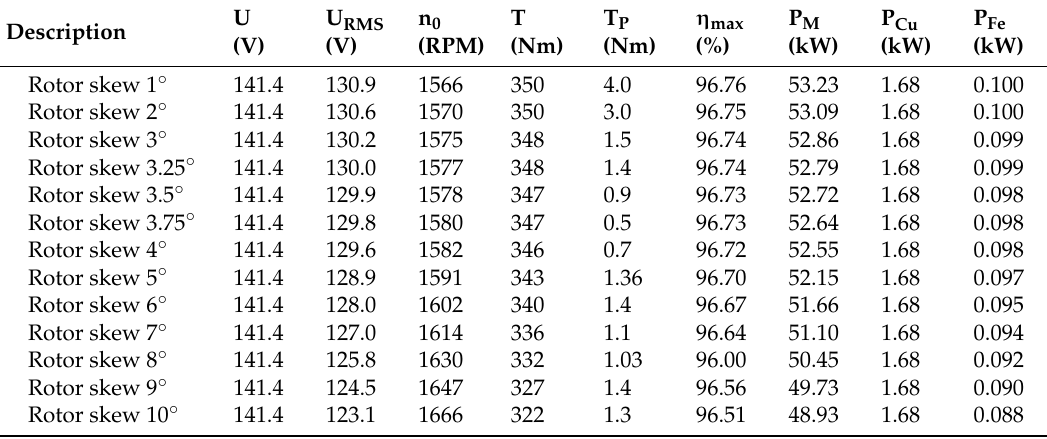
Table 11. The effect of skewing the rotor magnets on the obtained ERPMSM parameters.